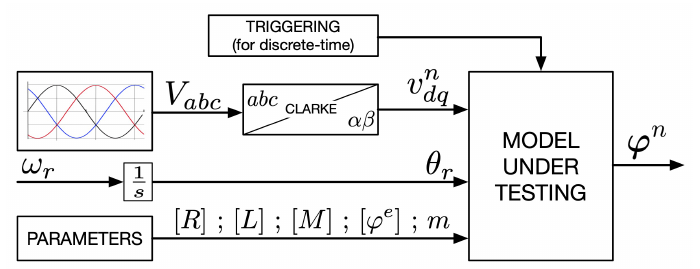
Figure 9. Model overview used for the tests of the Unified Machine